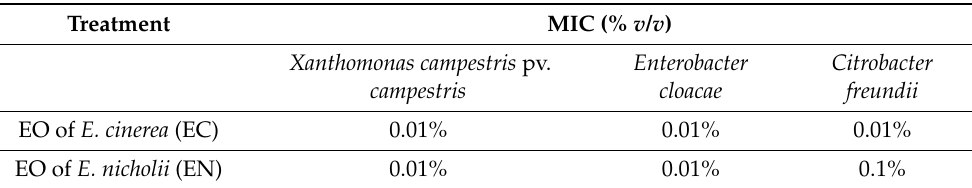
Table 5. Minimum inhibitory concentration (MIC) of the EOs extracted from E. cinerea and E. nicholii tested at different concentrations [% v / v